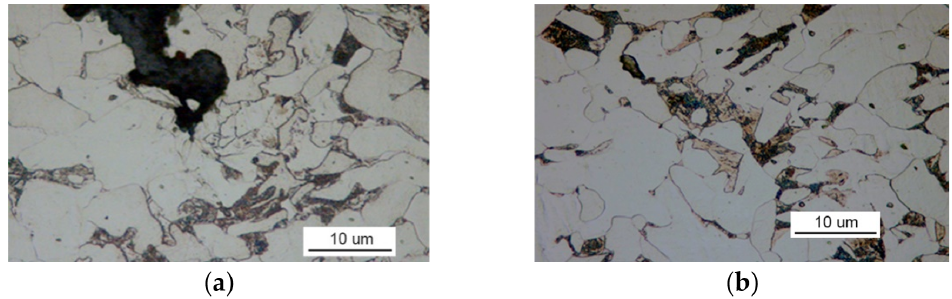
Figure 8. Optical microscopy views: ( a ) the face of the crack after etching with Nital and ( b ) the ferritic and pearlitic structure of the examined material (handy-size bulk carrier 30182